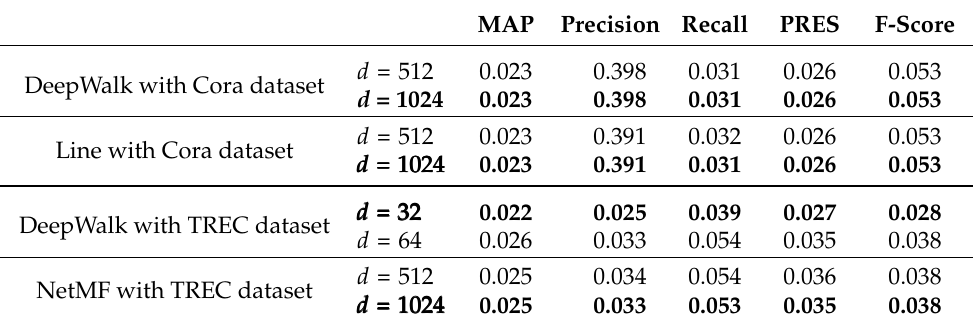
Table 14. Results of four extra experiments for suspicious cases. MAP Precision Recall PRES F-Score d = 512 DeepWalk with Cora dataset